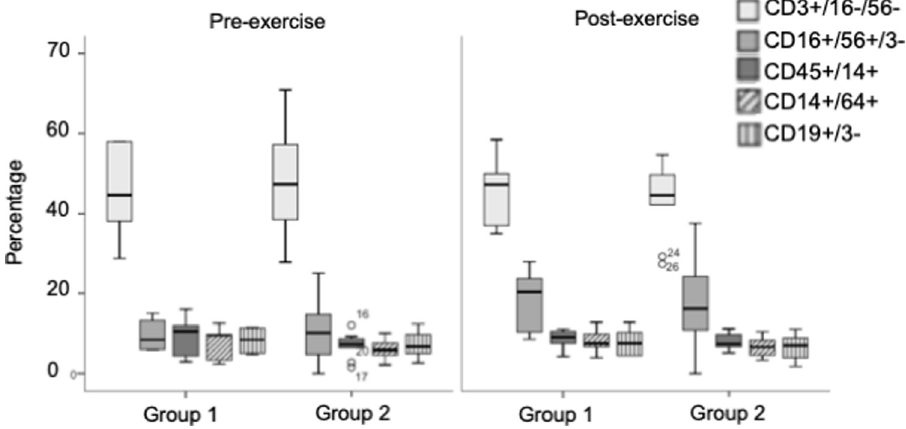
Fig 3. Percentage composition of PBMC in claudicants pre- and post-exercise separated by those who experiences a rise in urinary NAG/ Creatinine ratio (Group 1) vs. no rise on exercise (Group 2).